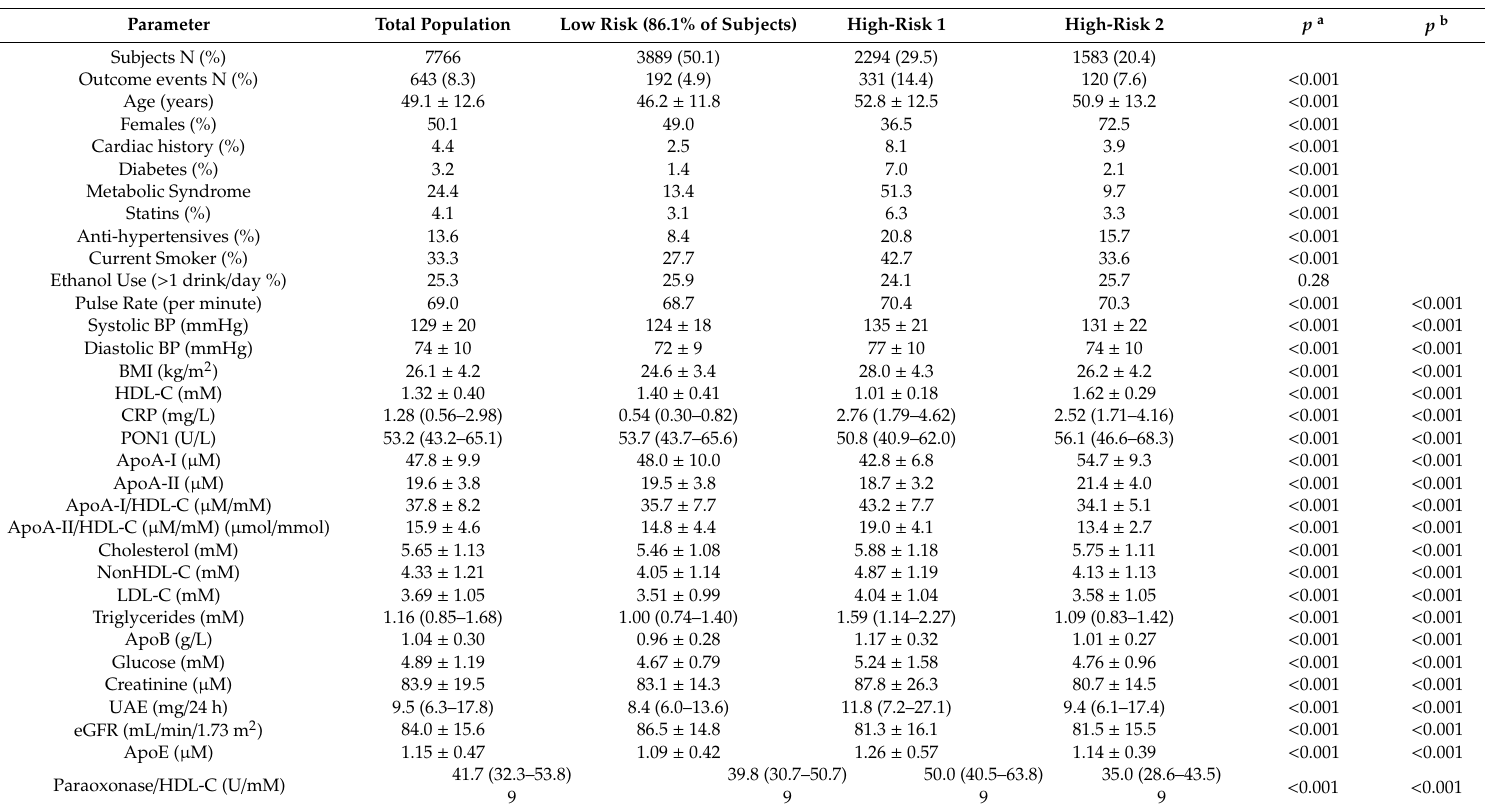
Table 1. Clinical and biomarker parameters for the total study population and low risk (LR), high-risk 1 (HR1), and high-risk 2 (HR2) subpopulations. Biomarker levels are given as means ± standard deviations for normally distributed parameters and medians with interquartile ranges for non-normally distributed